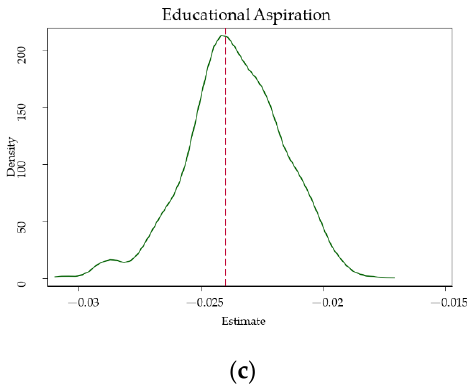
Figure 2. Distribution of estimated coefficients on student outcomes. Note: The figures present the distribution of estimated coefficients of parental absence on student outcomes, ( a ) distribution of estimates on cognitive test score, ( b ) distribution of estimates on the academic test score, and ( c ) distribution of estimates on educational aspiration.